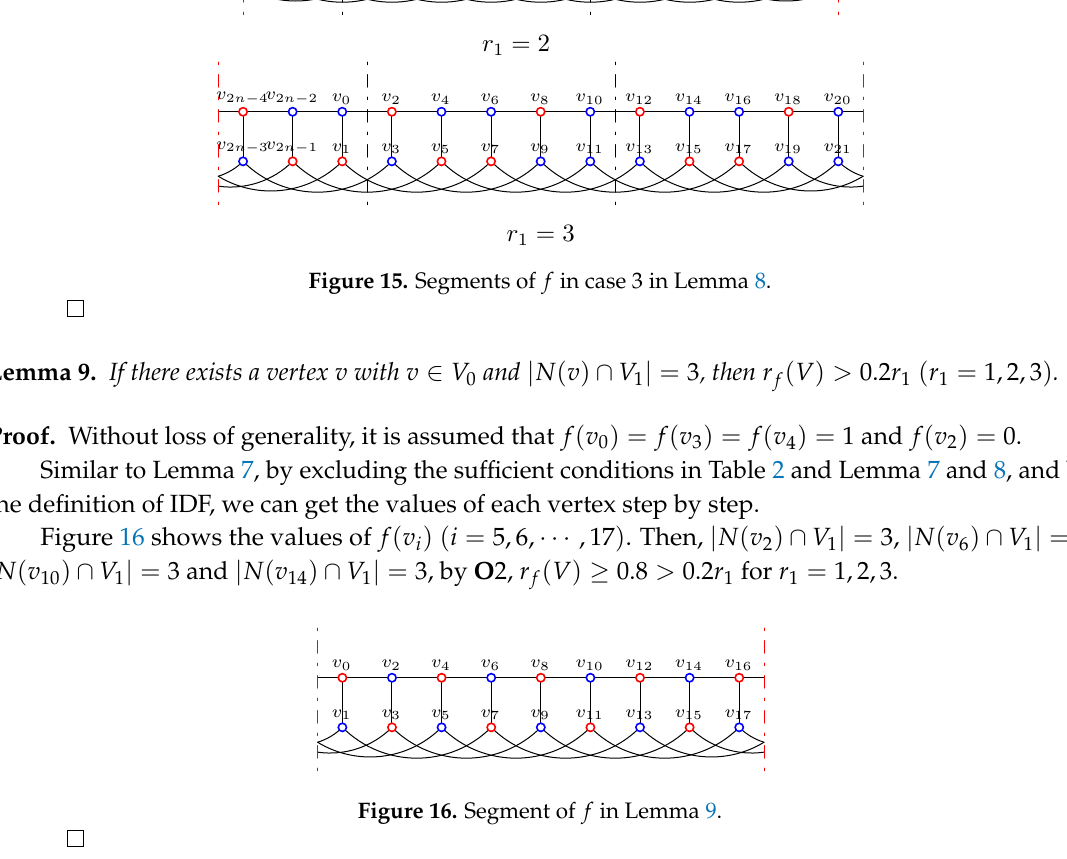
Figure 16. Segment of f in Lemma 9.